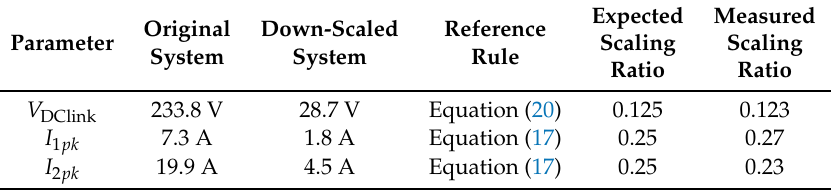
Table 4. DC bus voltage and currents of starting and down-scaled